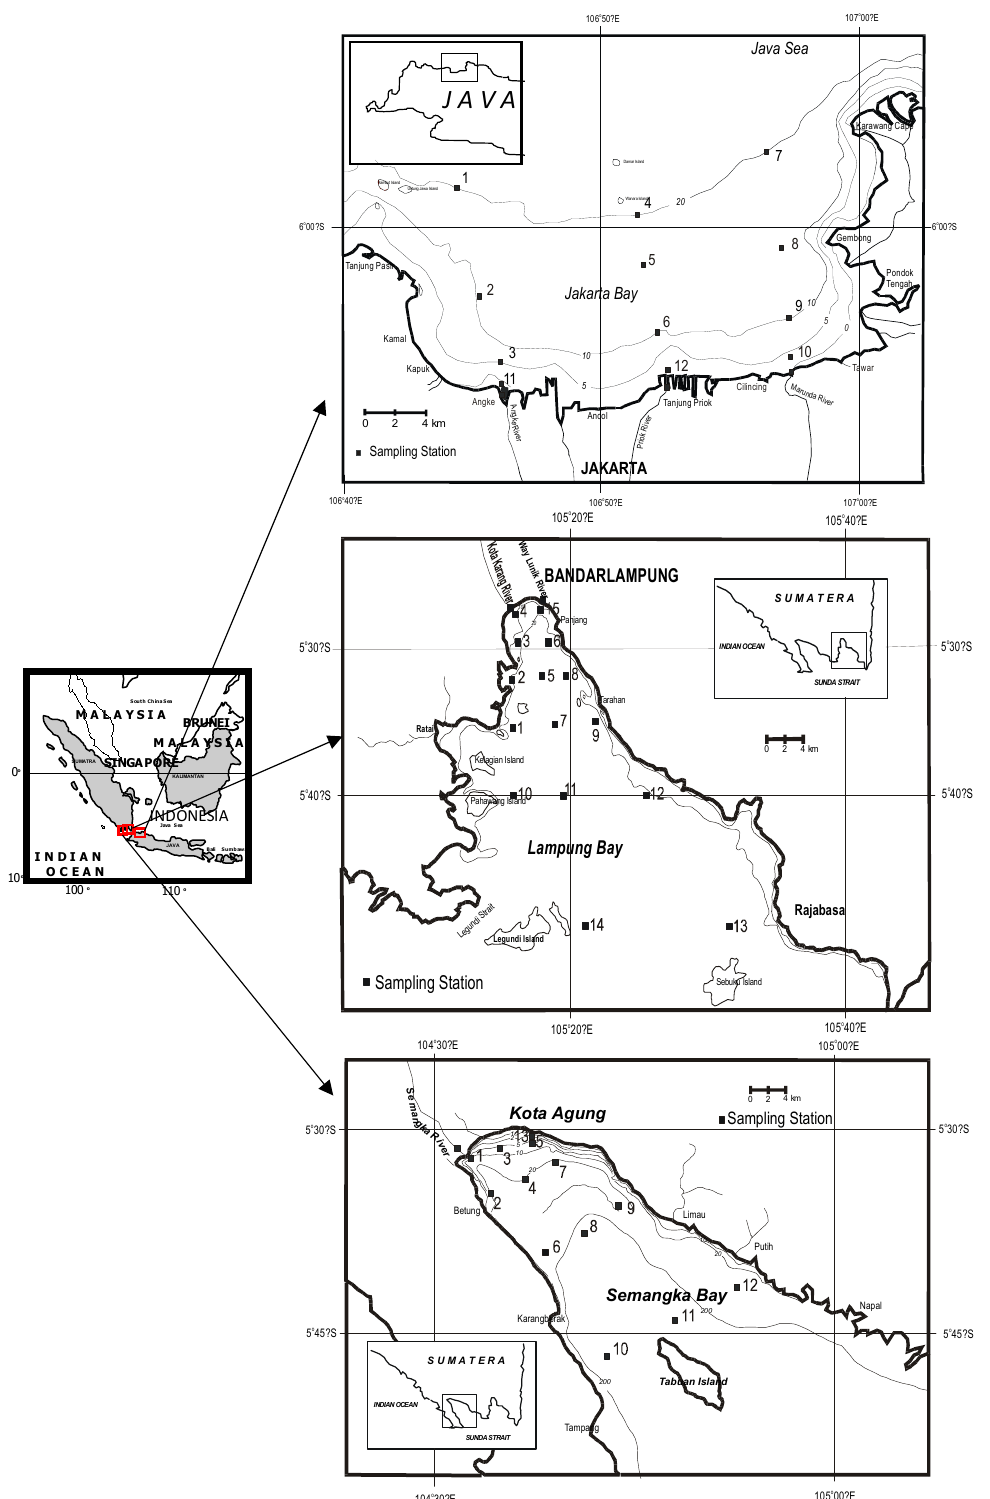
Figure 1. Sampling and measurement stations in Jakarta Bay (upper graph), Lampung Bay (middle graph), and Semangka Bay (lower graph) (redrawn after Damar [35] and Damar et al. [23]).